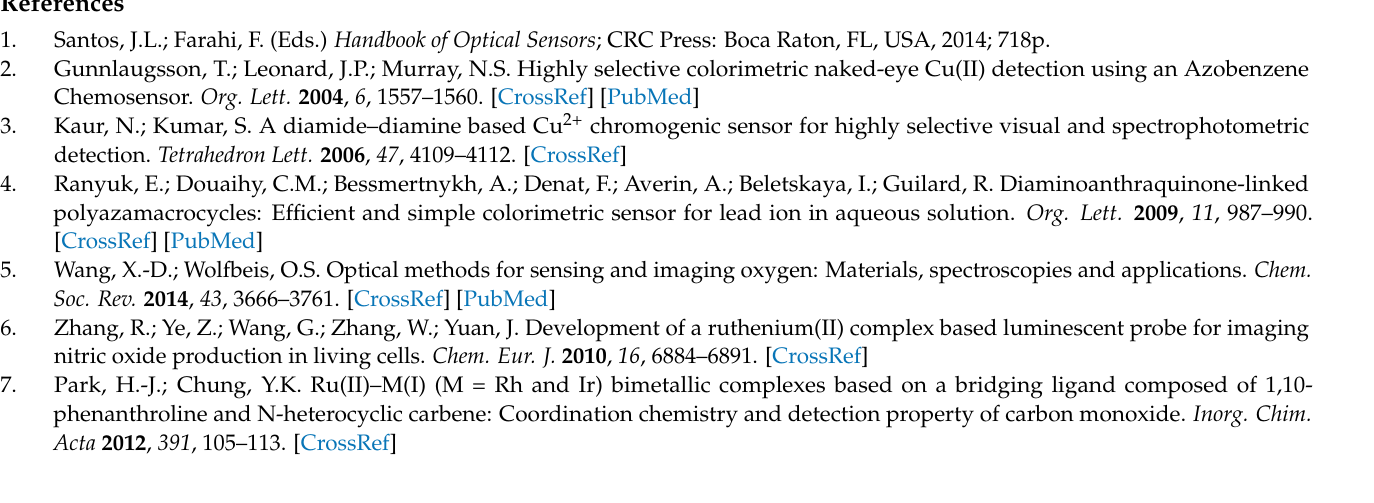
Figure S20: The structure of Ru(N 2 phen) complex obtained by full geometry optimization at B3LYP/6- 31G(d,p) level, Figure S21: The structure of Ru(N 2 Me 2 phen) complex obtained by full geometry op- timization at B3LYP/6-31G(d,p) level, Figures S22–S45: NMR spectra of new compounds, Figure S46: FTIR spectrum of Ru(Bnphen) (neat), Figure S47: FTIR spectrum of Ru(N 2 phen) (neat); Table S1: Optimization of the amination reaction conditions, Table S2: Calculated isodensity plot of the HOMO and LUMO orbitals for complex Ru(N 2 phen) , Table S3: Calculated isodensity plot of the HOMO and LUMO orbitals for complex Ru(N 2 Me 2 phen)